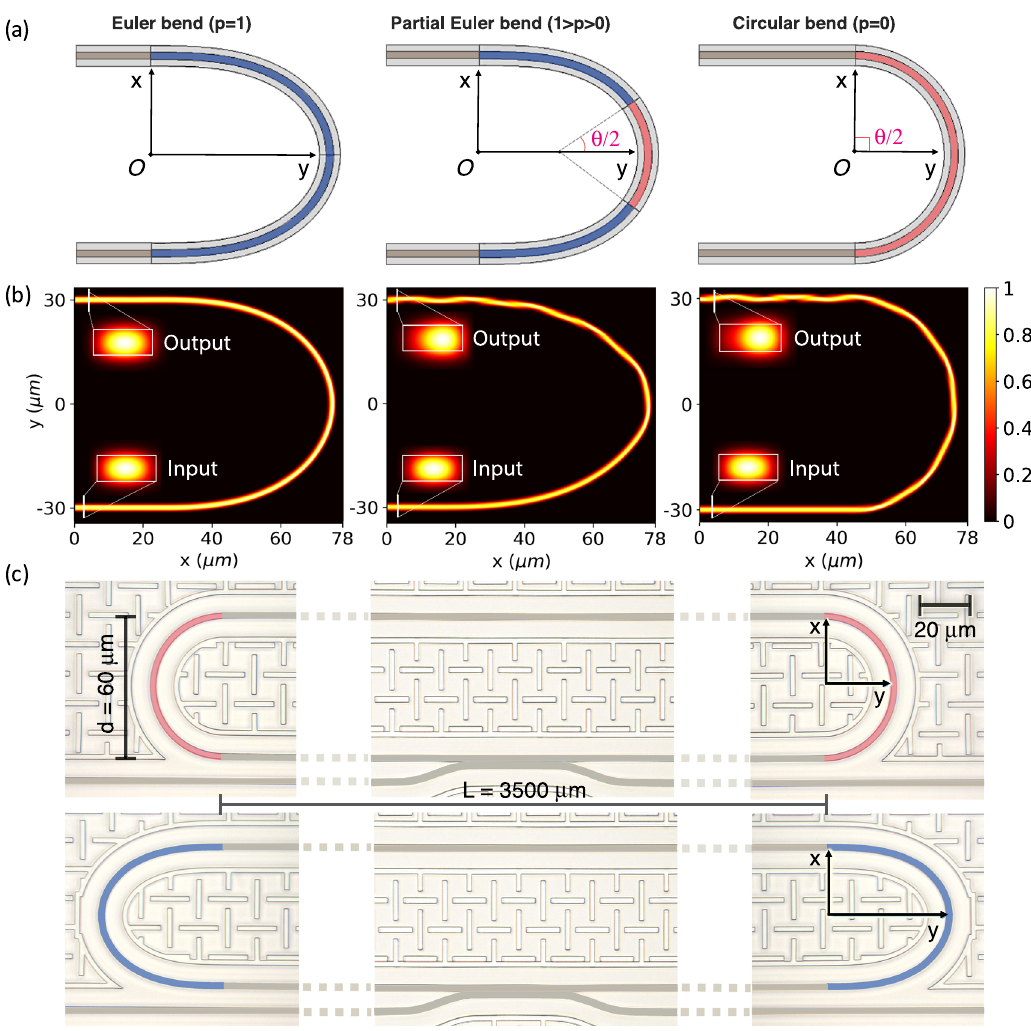
Fig. 1 Schematics, designs and simulations of Euler bends for integrated Si 3 N 4 racetrack microresonators. a Illustration of the difference between Euler bends (blue) and circular bends (red) in Cartesian coordinate system x -- y , to connect two straight waveguides (brown) in the racetrack microresonator within a π -bend (180 ∘ bend). The Euler portion factor p , which depends on the circular angle θ , denotes the ratio of Euler bends (blue) in the total π -bend. Here, p = 1 ( θ = 0), 1 > p > 0 ( π > θ > 0), and p = 0 ( θ = π ) corresponds to Euler bend, partial Euler bend, and circular Euler bend, respectively. b Finite- difference time-domain (FDTD) simulations of mode propagation in three different bends, showing that higher p offers better adiabatic mode conversion. In each case, the TE 00 mode of the straight waveguide is launched and propagates through the π -bend. Mode mixing during propagation is revealed by comparing the input and output modes, as well as the overall mode propagation pro fi les. It is observed that the launched TE 00 mode is preserved in the Euler bend ( p = 1), while it experiences distortion in the partial Euler bend ( p = 0.6) and circular bend ( p = 0). The color bar denotes the fi eld intensity in linear scale. c Optical microscope images showing fabricated Si 3 N 4 racetrack microresonators with Euler bends ( p = 1) and circular bends ( p = 0). Both racetrack microresonators have the same span of d = 60 μ m for the π -bends, and length of L = 3500 μ m. The device footprint is approximately 0.21 mm 2